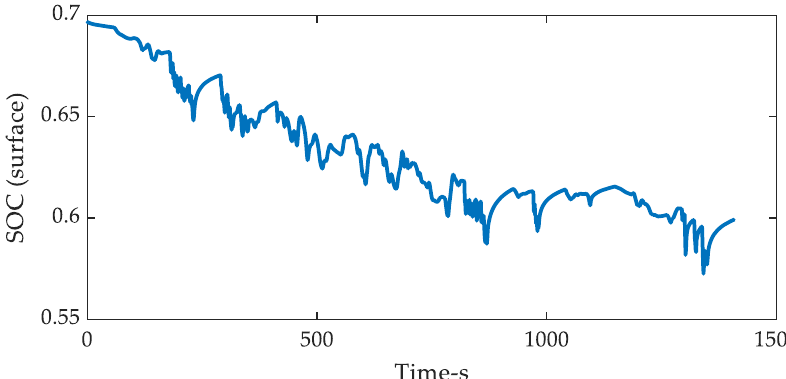
Figure 10. Variation curve of SOC on the surface of electrode particles with time.